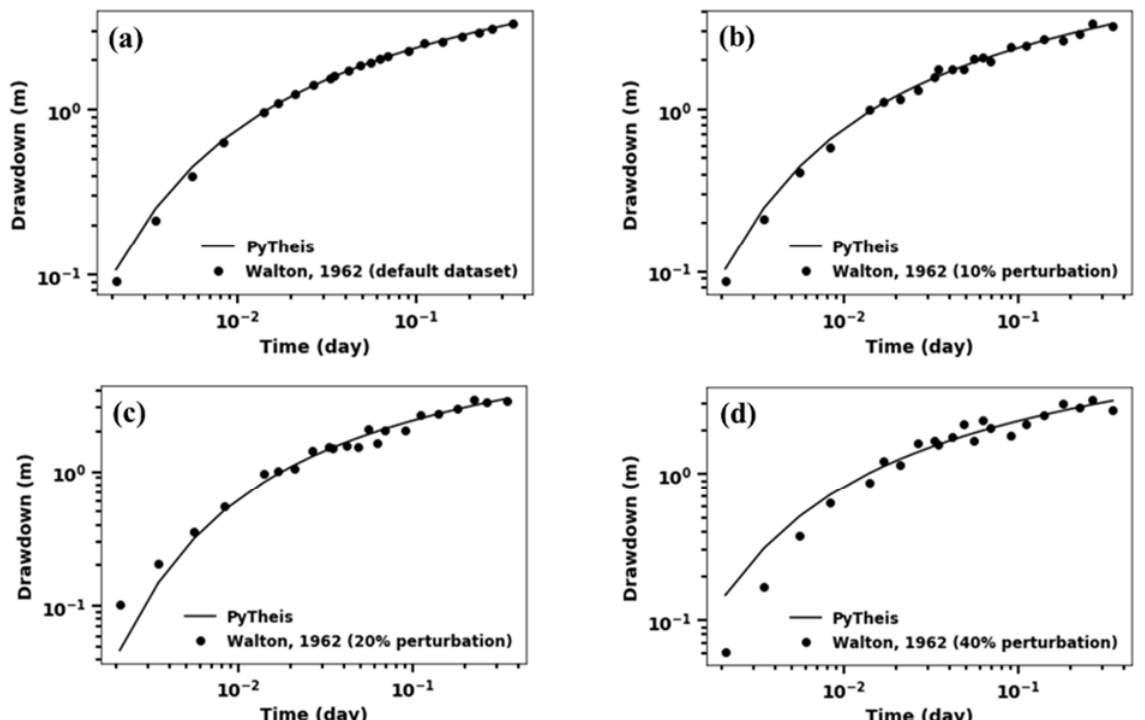
Figure 4. Log–log scale time-drawdown curves fitted using the PyTheis code for the perturbed Walton (1962) problems: ( a ) base case data, ( b ) ±10% perturbation, ( c ) ±20% perturbation, and ( d ) ±40% perturbation. Table 3. PyTheis estimated T and S values for the perturbed Walton (1962) datasets.